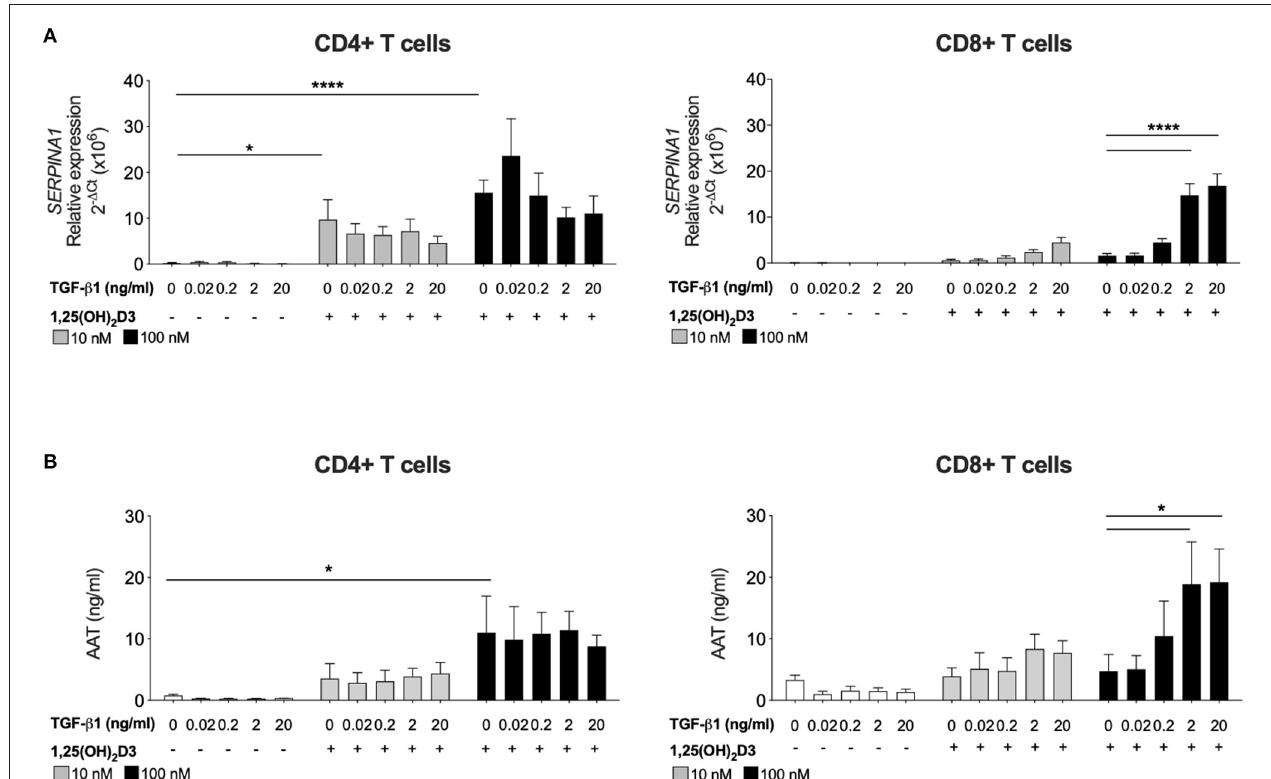
FIGURE 2 | CD8 + T cells require exogenous TGF- β 1 to enhance 1,25(OH) 2 D3-induced SERPINA1 /AAT. CD4 + and CD8 + T cells ( n = 6) were stimulated and cultured for 7 days in the absence or presence of 10 or 100nM 1,25(OH) 2 D3, with or without TGF- β 1 (0.02, 0.2, 2, 20ng/ml). (A) Gene expression of SERPINA1 was quantified by qRT-PCR. (B) Culture supernatants were assessed for AAT protein secreted by ELISA. Data are expressed as mean ± SEM and statistical analysis employed a 2-way ANOVA with Bonferroni post-tests with * p < 0.05, **** p < 0.0001. (100 nM) VDR in both CD4 + and CD8 + T cells ( Figure 2A